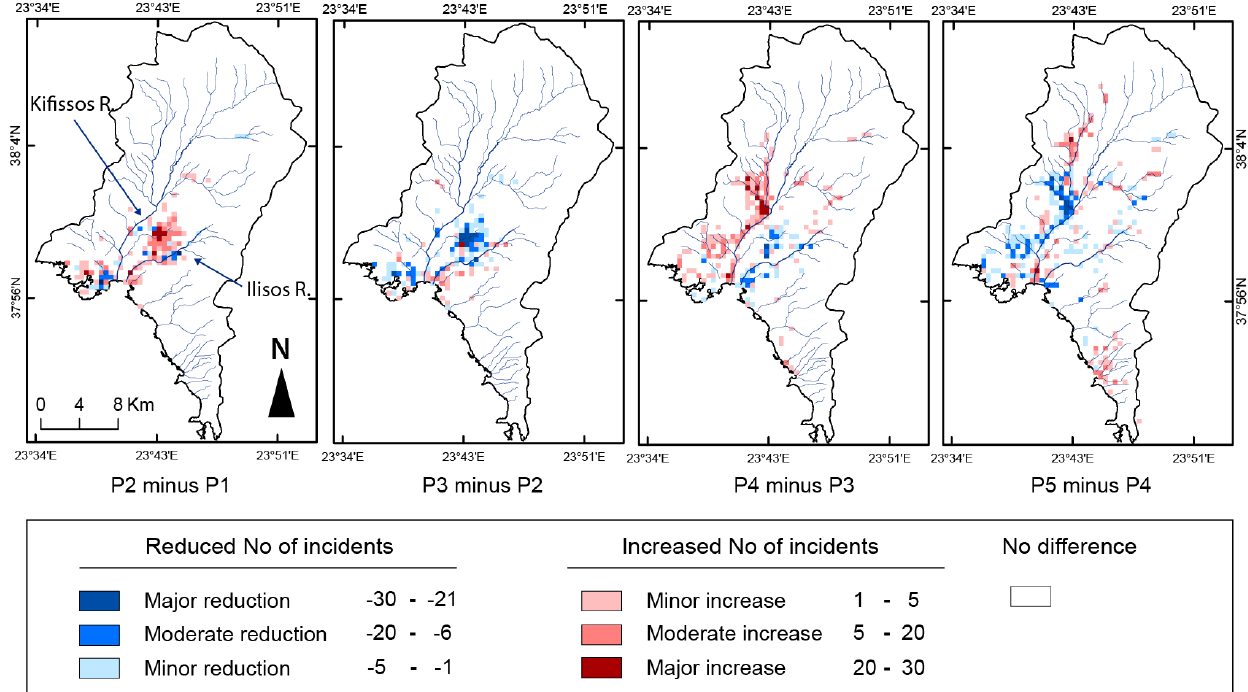
Figure 5. Spatio-temporal differences of incident locations count between successive segments of the study period through subtraction of respective grids on a cell-by-cell